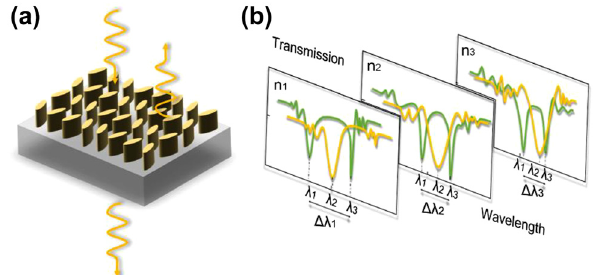
Figure 1: Schematic diagram of the metasurface for dual-resonance sensing. (a) Sketch of the metasurface. (b) Schematic diagram of the principle for single-resonance sensing (yellow curve) and dual-resonance sensing (green